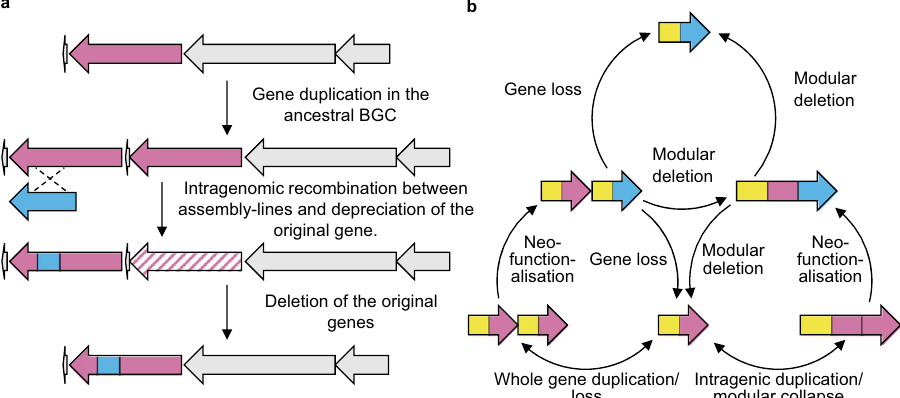
Fig. 6 The evolution of biosynthetic assembly-lines. a Proposed evolutionary history of the wollamide ( wol ) and desotamide ( dsa ) BGCs. b An updated model for the evolution of biosynthetic